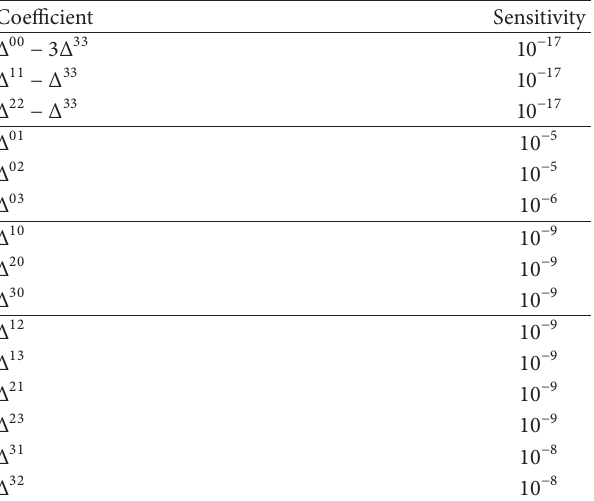
Table 1: Maximal sensitivities ( 2𝜎 ) for the Lorentz violation matrix of photons.